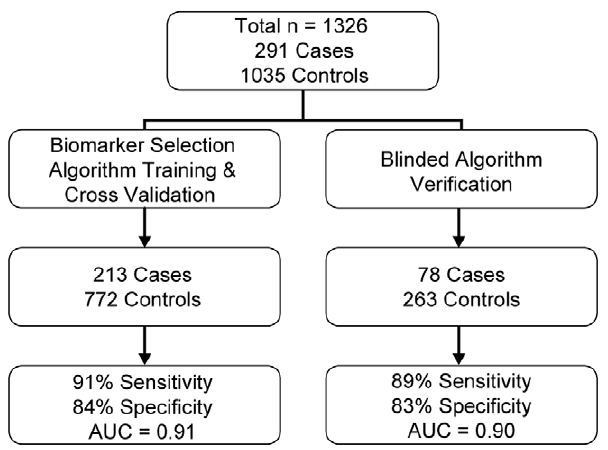
Figure 1. Study Flow for Algorithm Training and Verification.